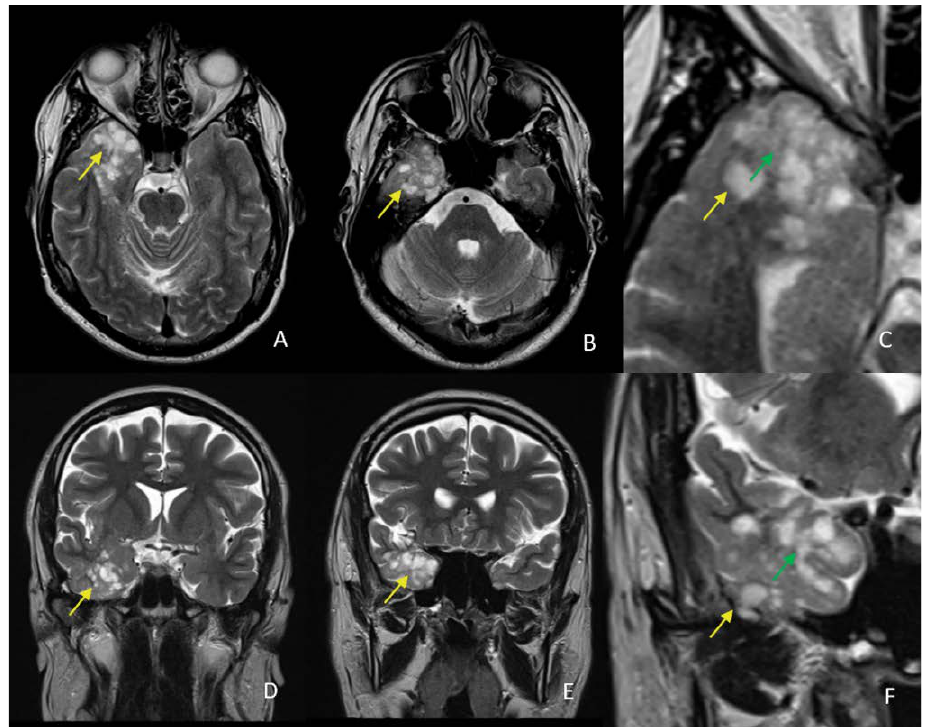
Figure 3. T2wi in axial ( A , B ) and coronal ( D , E ) planes with correspondent zoomed images ( C , F ) on the temporal lesion reveals hyperintense nodules (yellow arrow) at the cortical–subcortical white matter junction with areas of high signal intensity between them (green